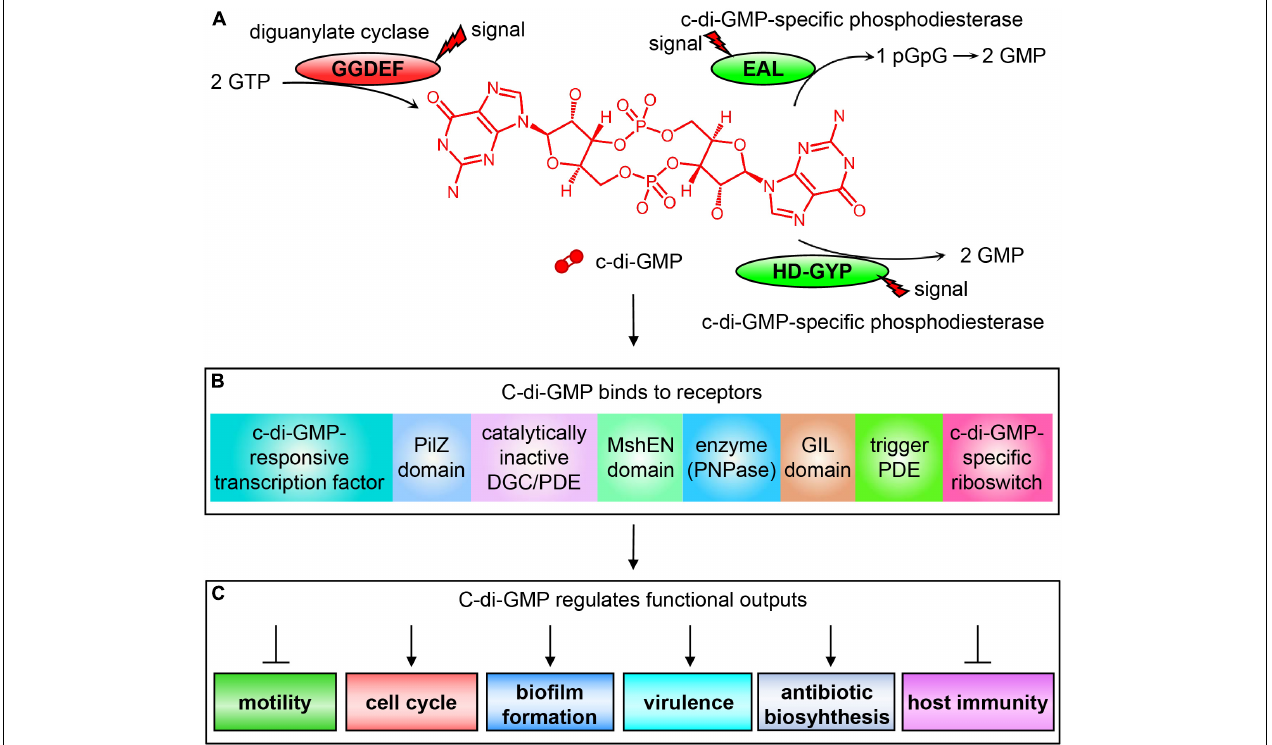
FIGURE 2 | Schematic diagram of c-di-GMP signal transduction system. (A) The synthesis and degradation of c-di-GMP depending on the DGCs containing the GGDEF domain and c-di-GMP-specific PDEs containing EAL or HD-GYP domain. (B) The c-di-GMP receptors found in bacteria that bind to c-di-GMP for exerting their regulatory functions. (C) Different physiological phenotypes of bacteria regulated by c-di-GMP binding to